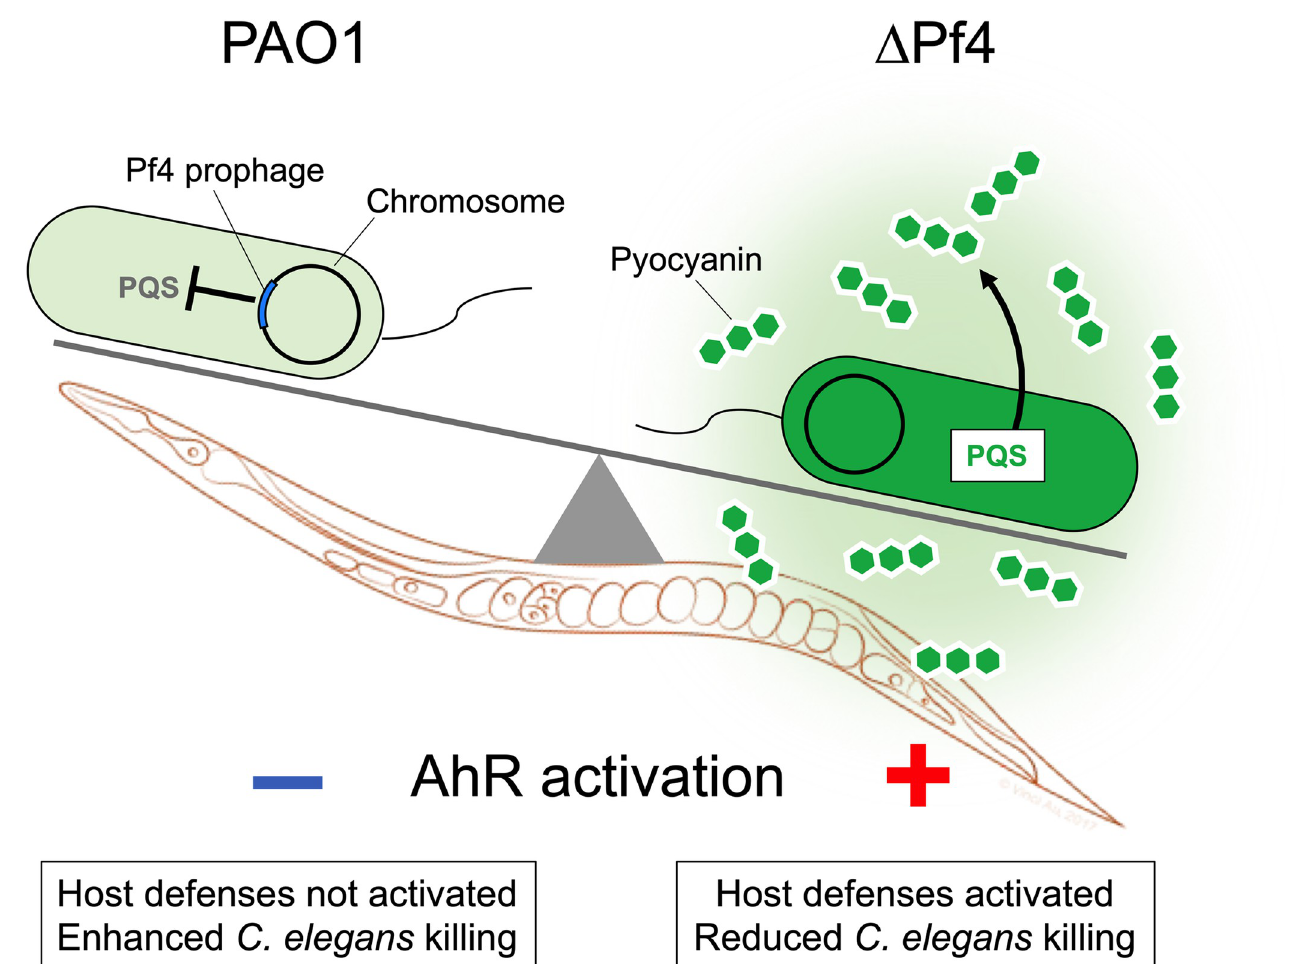
Fig 7. Proposed model. Pf4 suppresses the production of quorum-regulated pigments by P . aeruginosa allowing bacteria to evade AhR-mediated immune responses in C . elegans .